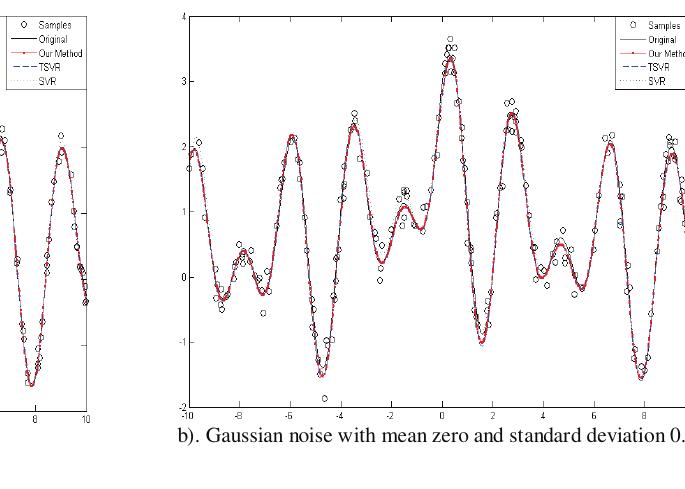
Figure 1: Results of approximation of with our method, SVR and TSVR when different kinds of additive noise were used. Gaussian kernel was